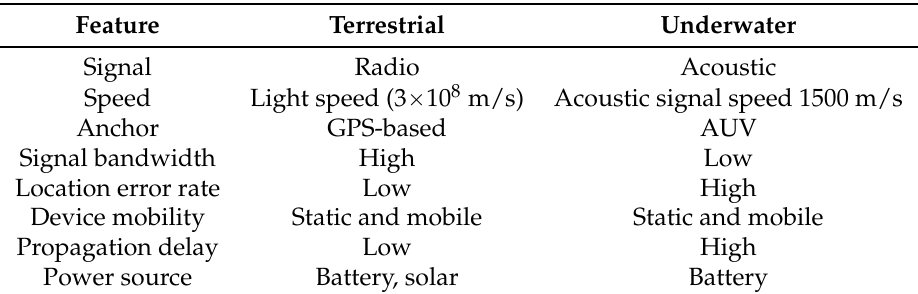
Table 1. Characteristic differences between terrestrial wireless sensor networks (TWSN) and underwater wireless sensor networks